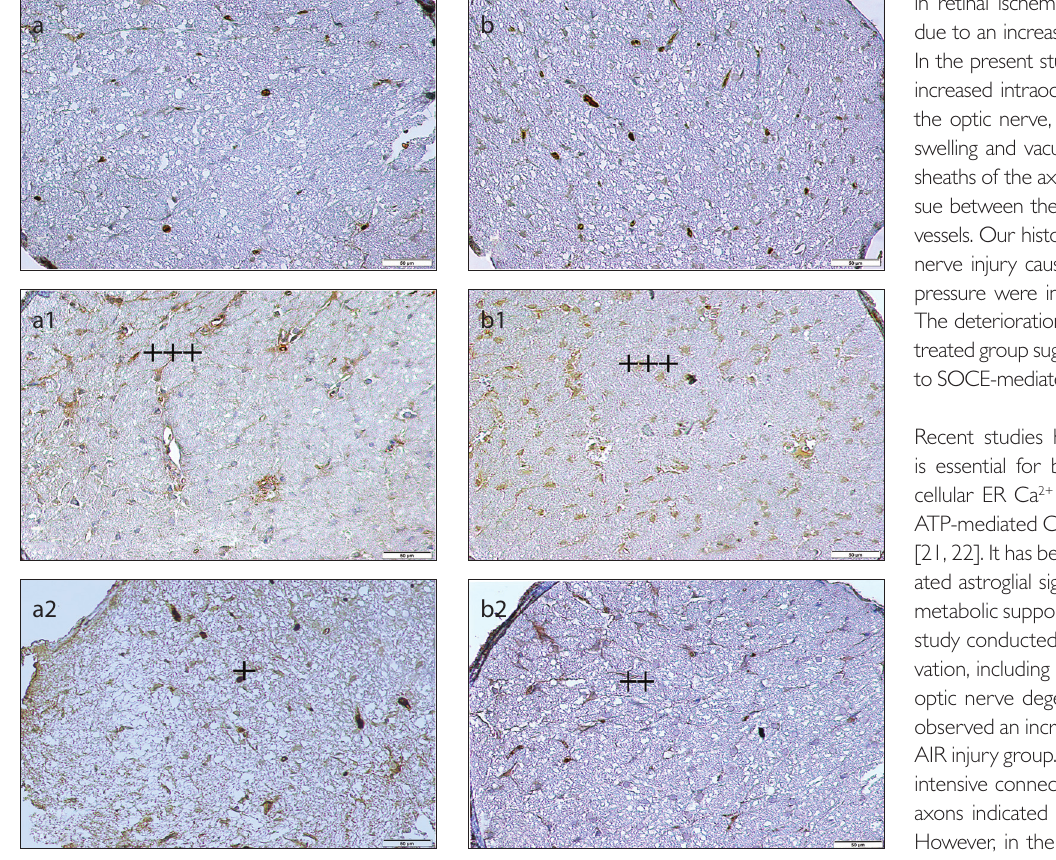
Figure 3. a, b Light photomicrographs of Orai1 (a-a2) and STIM1 (b-b2) immunohistochemistry of optic nerve tissues. (a, b) Sham groups; (a1-b1) AIR groups; (a2-b2) AIR10 groups. (+), mild staining; (++), moderate staining; (+++), severe staining. Bars: 50